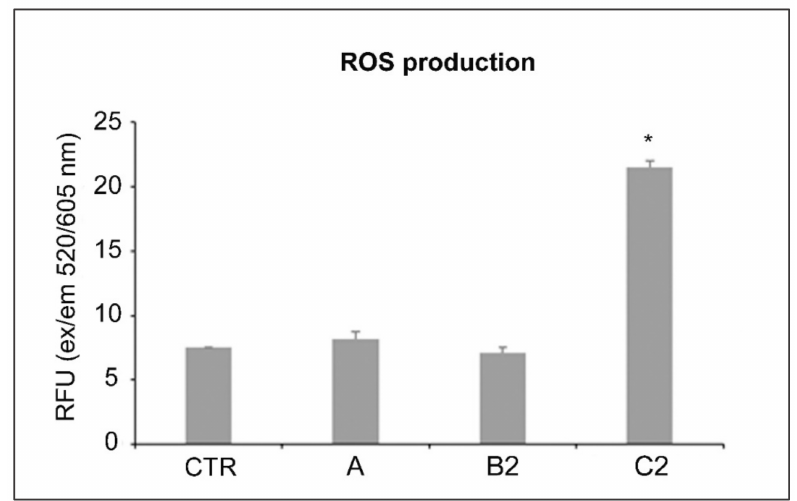
Figure 5. ROS production for the LCWBs: untreated (CTR), treated with the A condition, and treated with the B2 and C2 combinations. For the experimental points, see Figure 1 and the Section 4, paragraph 5. * Statistically significant difference from the CTR ( p <